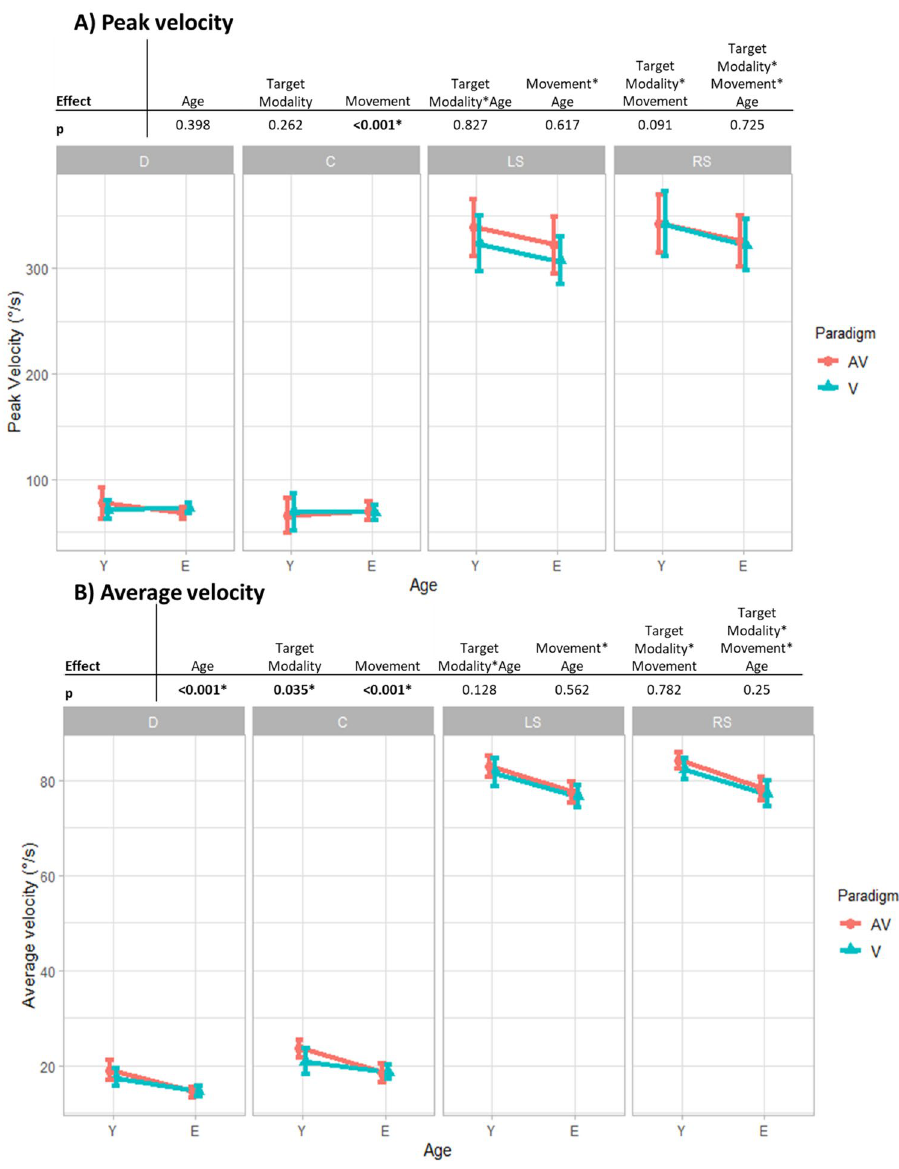
Figure 2. Summary of the main and interaction effects of the 3-way ANOVA with repeated measures for velocity ( A for peak velocity and B for average velocity). Velocity means and 0.95 confidence intervals given as a function of movement (D for divergence, C for convergence, LS for left saccade, RS for right saccade), age group (Y for young group, E for elderly group) and modality target (AV for audiovisual target, V for visual